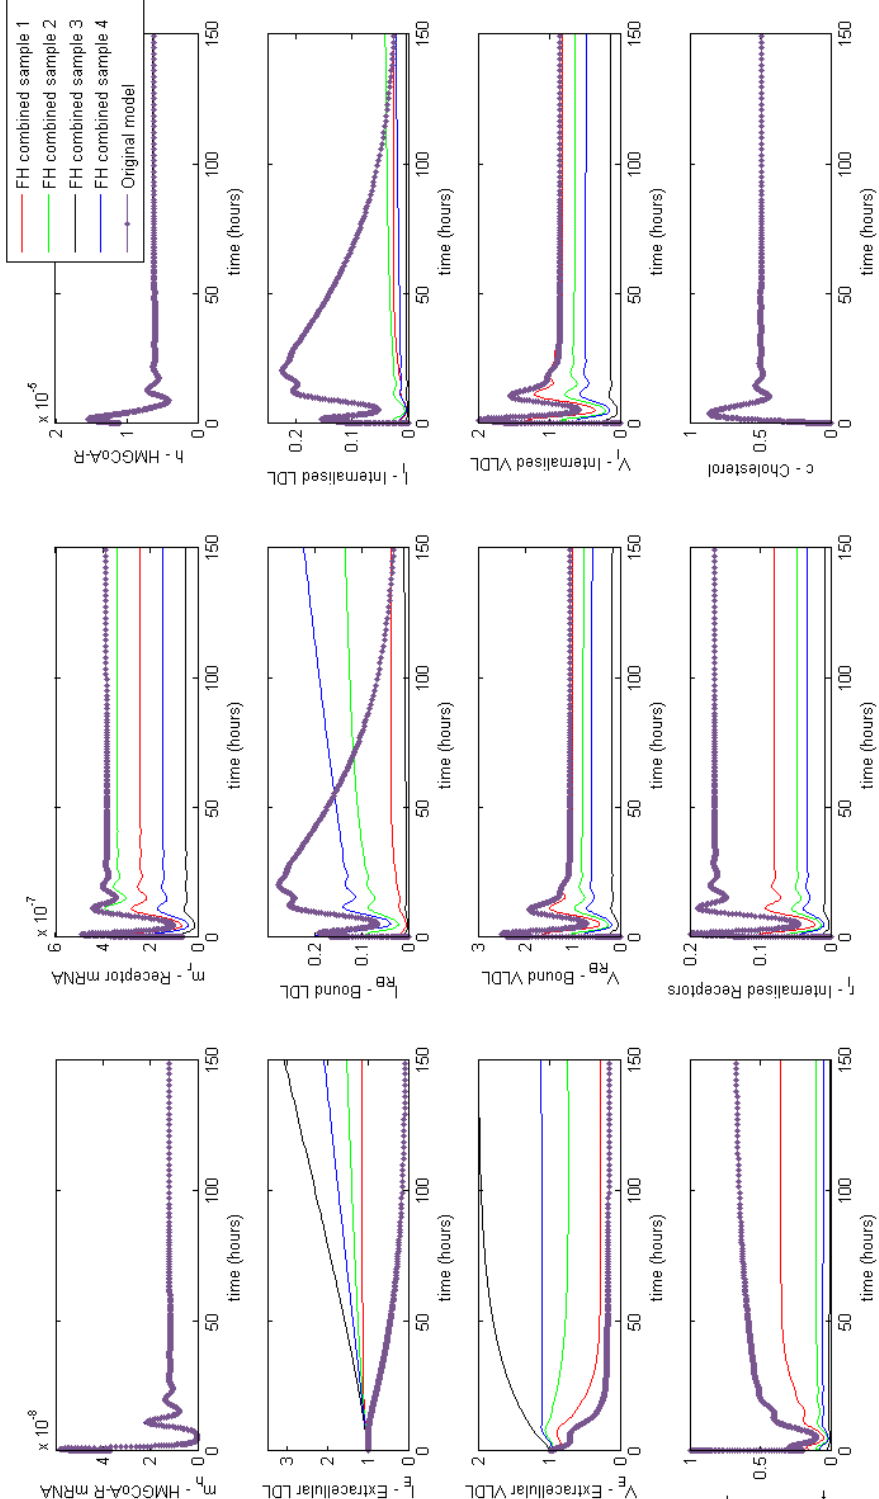
Figure A5. Familial Hypercholesterolaemia combined effects. Showing a combination of reduced synthesis production and recycling and ineffective LDL binding and internalisation can dramatically increase levels of circulating LDL and